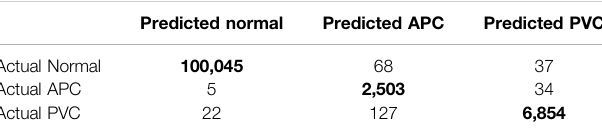
Frontiers in Signal Processing |